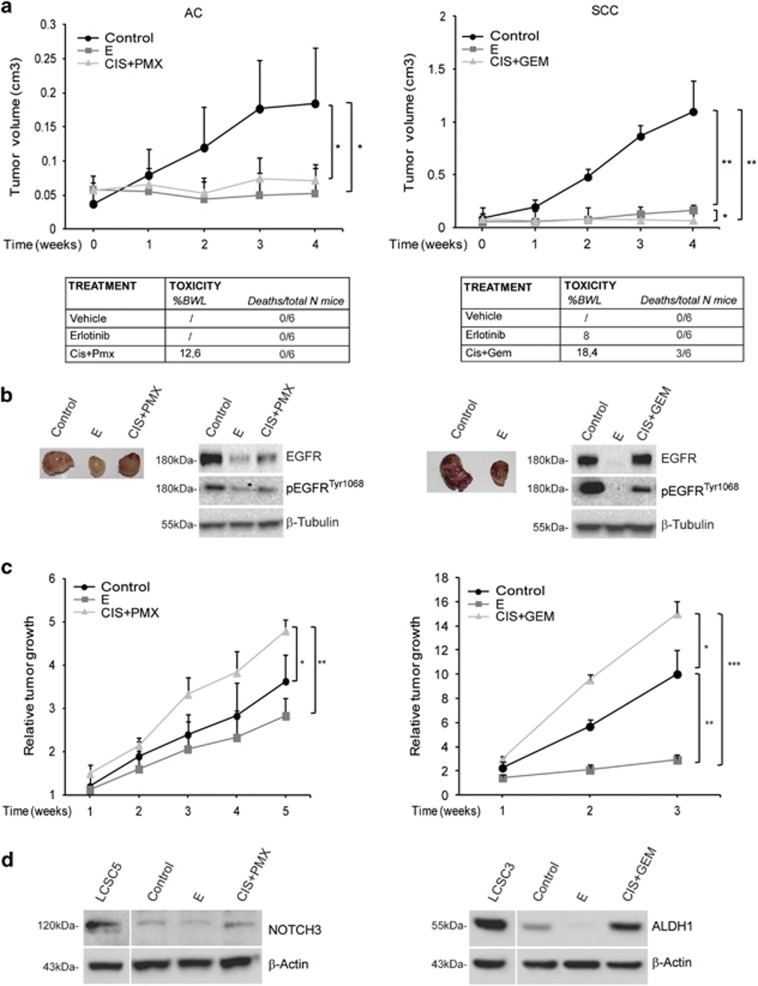
The in vivo antitumor activity of Erlotinib or chemotherapy in LCSC-generated adenocarcinoma (ADC) or squamous cell carcinoma (SCC) xenografts. (a, upper panels) Growth curves of LCSC-derived xenografts in control mice or mice treated with erlotinib, cisplatin/pemetrexed combination (Cis+Pem) or cisplatin/gemcitabine combination (Cis+Gem), as indicated (). Mean±S.D. of three independent experiments is shown. *P<0.05; **P<0.01. (a, lower panels) Table of drug-induced systemic toxicity in the three groups of mice indicated as percentage of body weight loss (BWL) or number of deaths/total number of mice. (b) Images of tumors at the end of each treatment and immunoblot analysis of EGFR/pEGFRtyr1068 in cells obtained from control or treated tumors. (c) Relative tumor growth of control or pretreated tumors after treatment interruption. Relative tumor growth is indicated as ratio of tumor volume at the indicated week after drug suspension versus volume at the last day of treatment. *P<0.05; **P<0.01; ***P<0.001. (d) Immunoblot analysis of the indicated CSC-related proteins in control or treated xenografts in comparison with their corresponding LCSCs